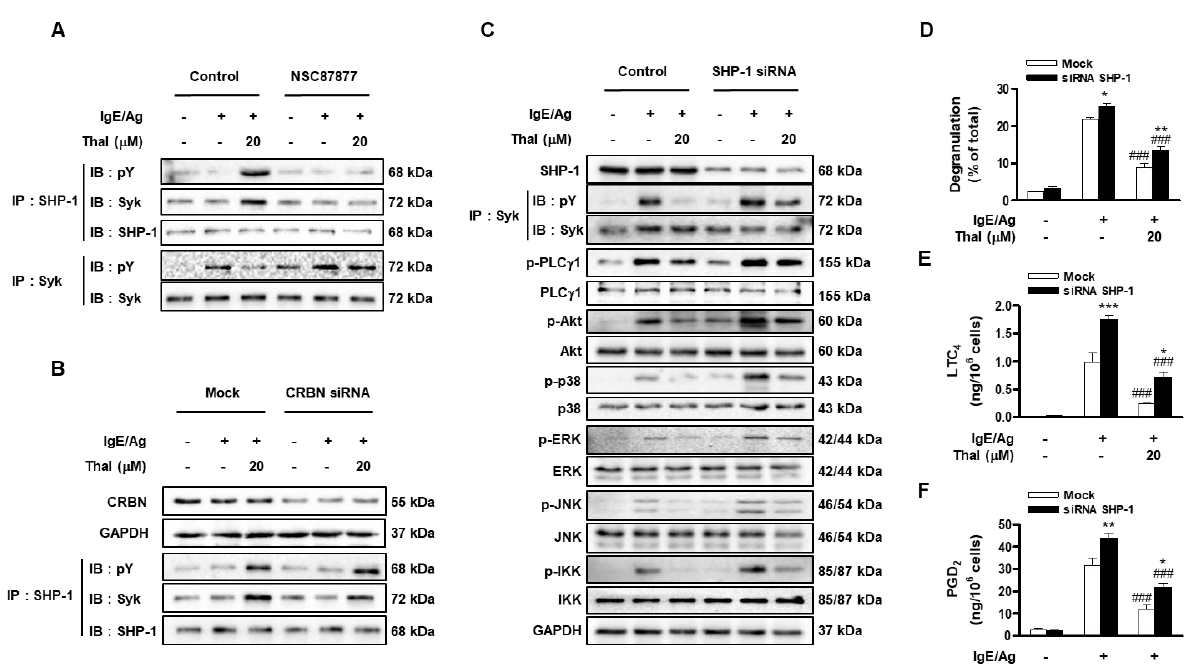
Figure 5. Thalidomide increases SHP-1 phosphorylation and protein interactions of SHP-1 with Syk in IgE/Ag-stimulated BMMCs. IgE-sensitized BMMCs were pretreated with 20 μM of NSC87877 ( A ), CRBN siRNA ( B ), or SHP-1 siRNA ( C - F ), and then stimulated with DNP-HSA (Ag) for 15 min in the presence or absence of thalidomide (Thal). The immunoprecipitates or whole cell lysates were subjected to immunoblot analysis and data are representative of three independent experiments ( A – C ). Degranulation ( D ) and the secretion of LTC 4 ( E ) and PGD 2 ( F ) were evaluated. Data indicate the means ± SEM (n = 3, * p < 0.05, ** p < 0.01, and *** p < 0.001 vs. Mock in each treatment; ### p < 0.001 vs. IgE/Ag alone in each group).